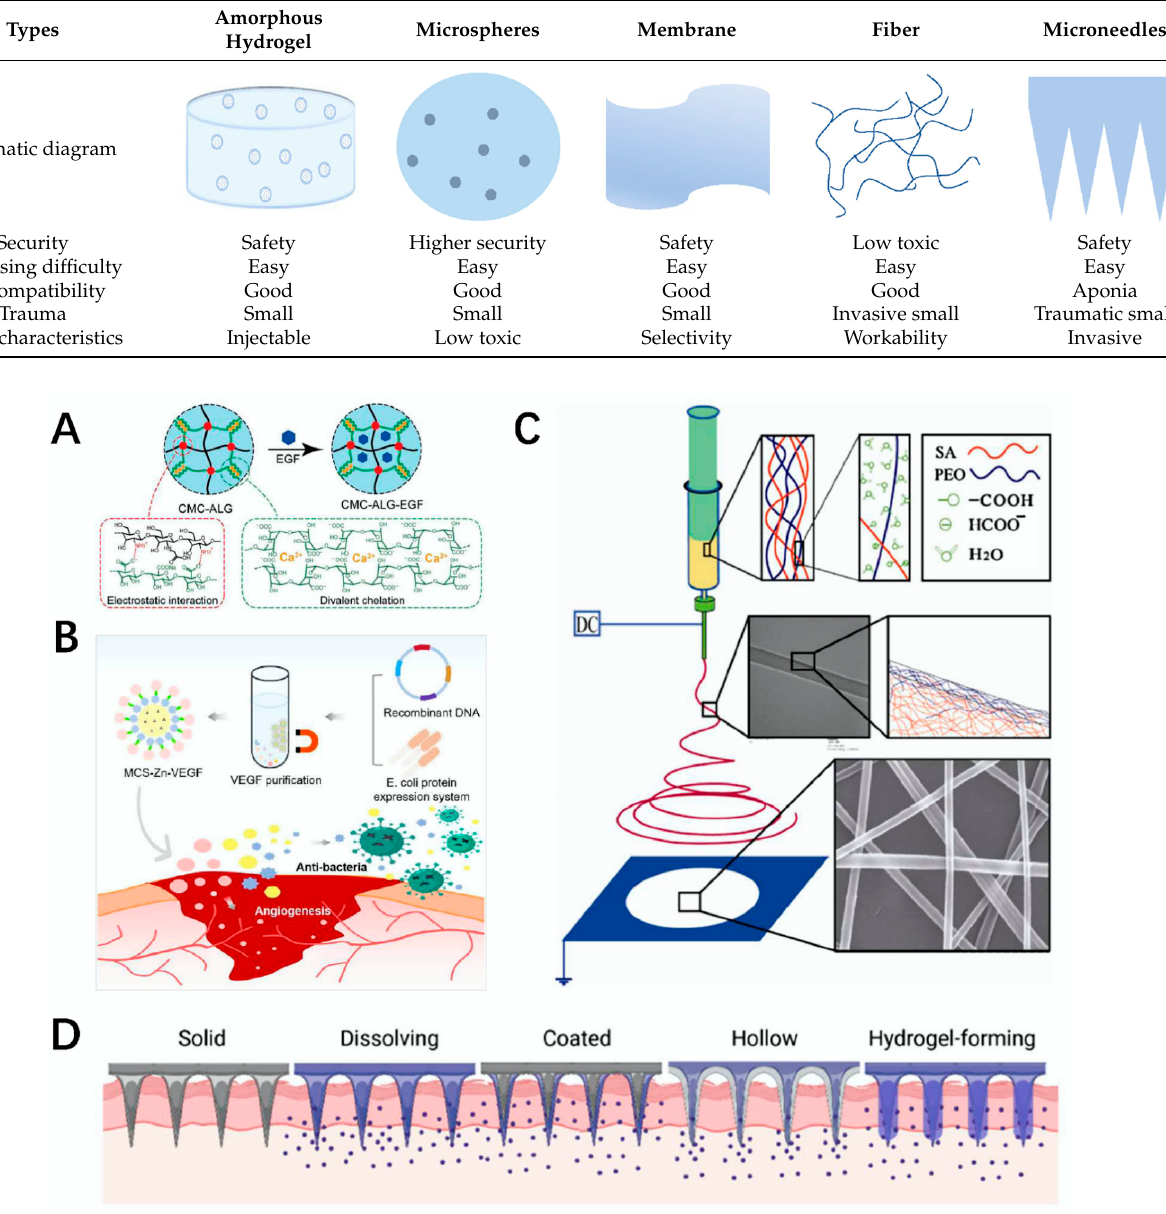
Figure 5. Preparation and application of polysaccharide composite materials and classification of microneedles. ( A ) schematic diagram of an amorphous hydrogel structure made by CMC, SA, and EGF [79]. ( B ) preparation and application of MCS microspheres in wound healing [81]. ( C ) schematic diagram of the preparation of SA/PEO nanofiber membranes [4]. ( D ) classification of microneedles [82].